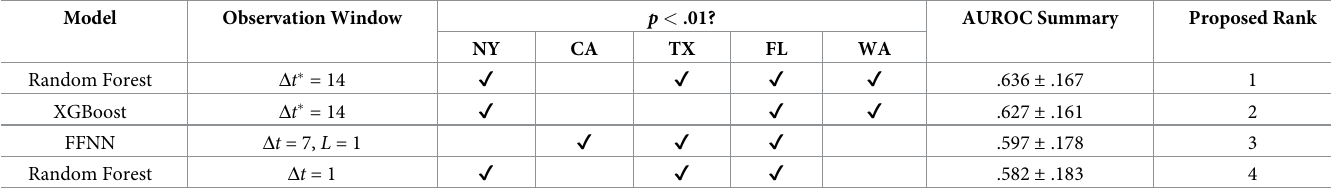
Table 2. Summary of models whose outputs were statistically significant on at least 3